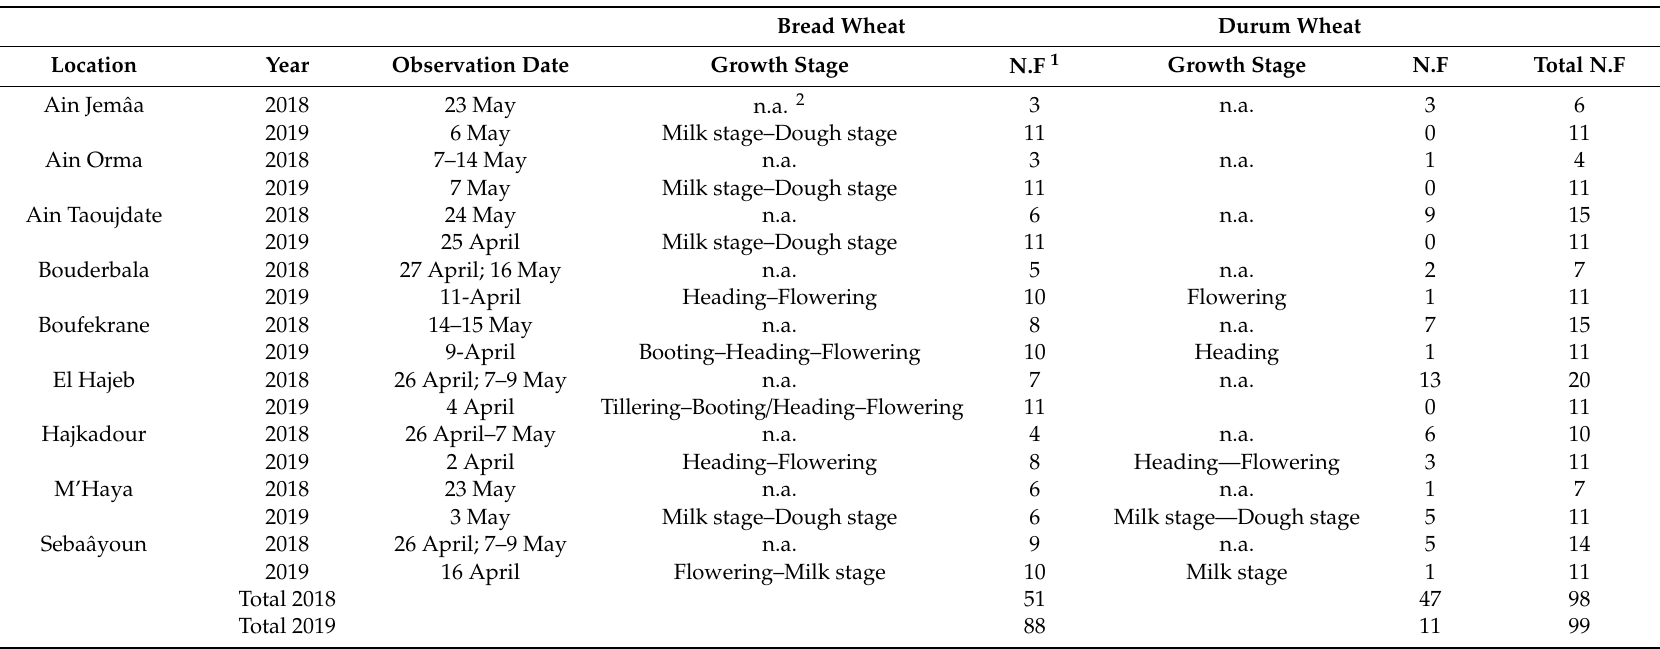
Table 1. Agronomic details for bread and durum wheat at all surveyed sites in Morocco during the 2017 / 2018 and 2018 / 2019 cropping seasons. Bread